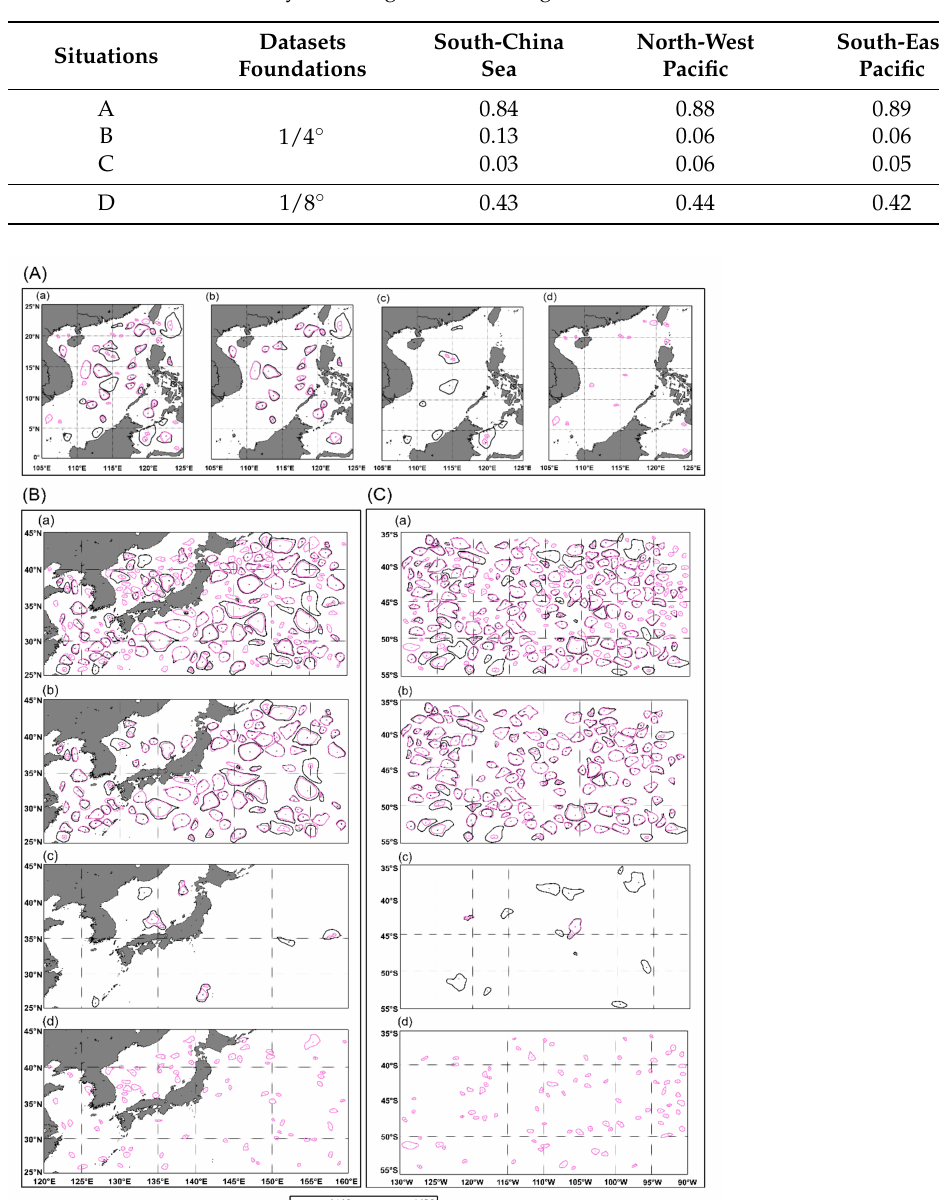
Table 6. Probabilities of eddy matching in the three regions.